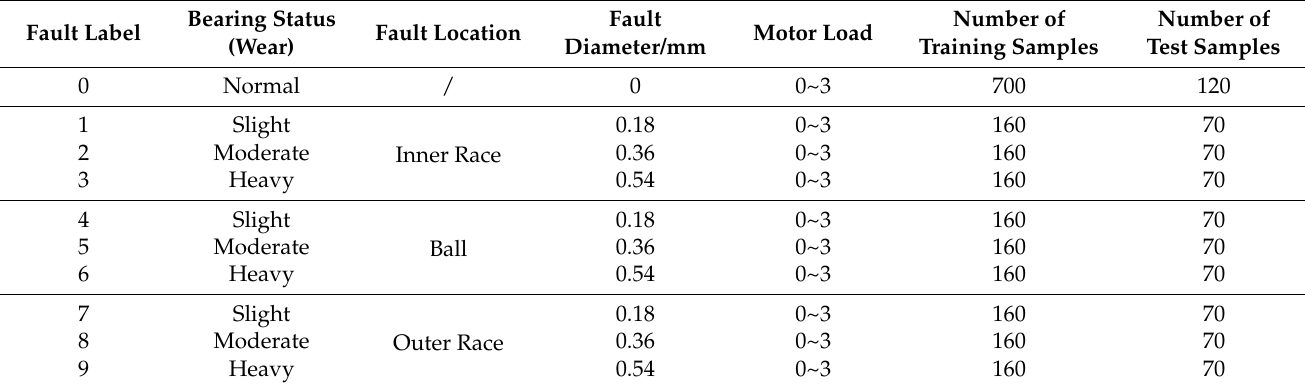
Table 1. CWRU experimental data